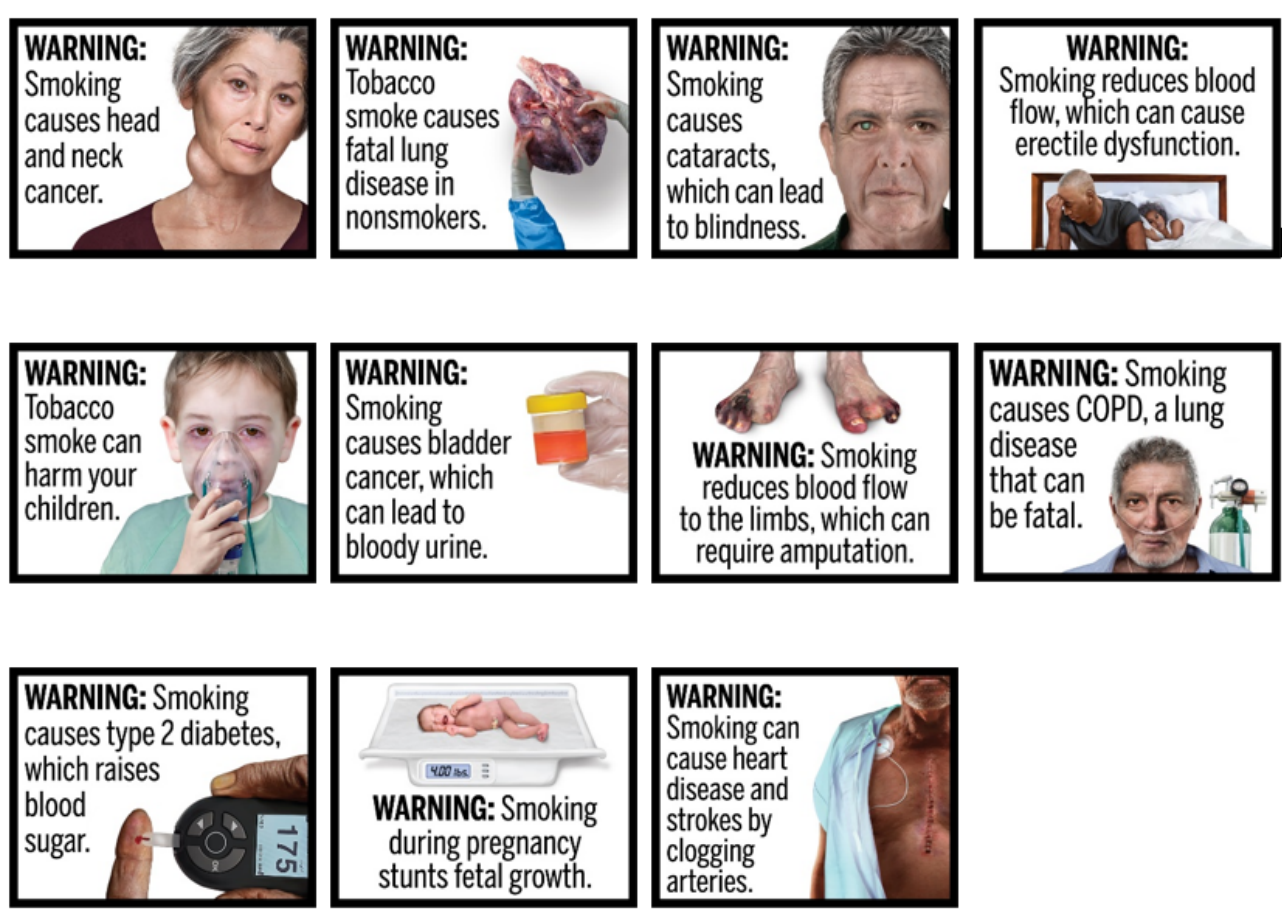
Figure 2. Cigarette labels proposed in 2019 [34].